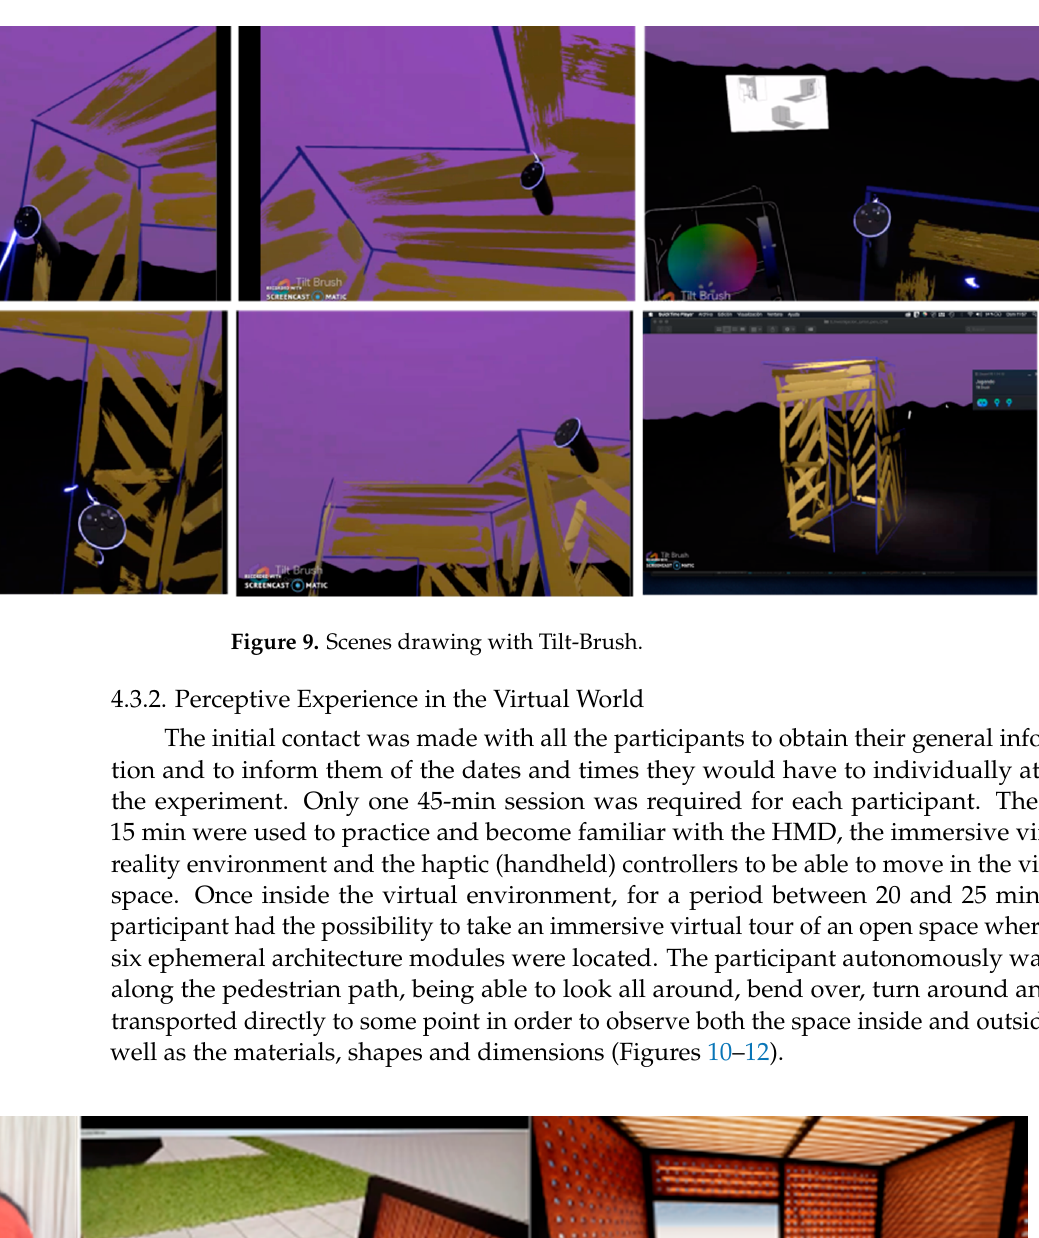
Figure 11. Tour of architectural spaces.